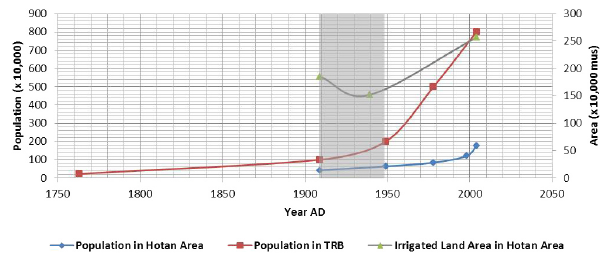
Fig. 7. Dynamics of human population and farmland area in Hotan region and over the whole Tarim River